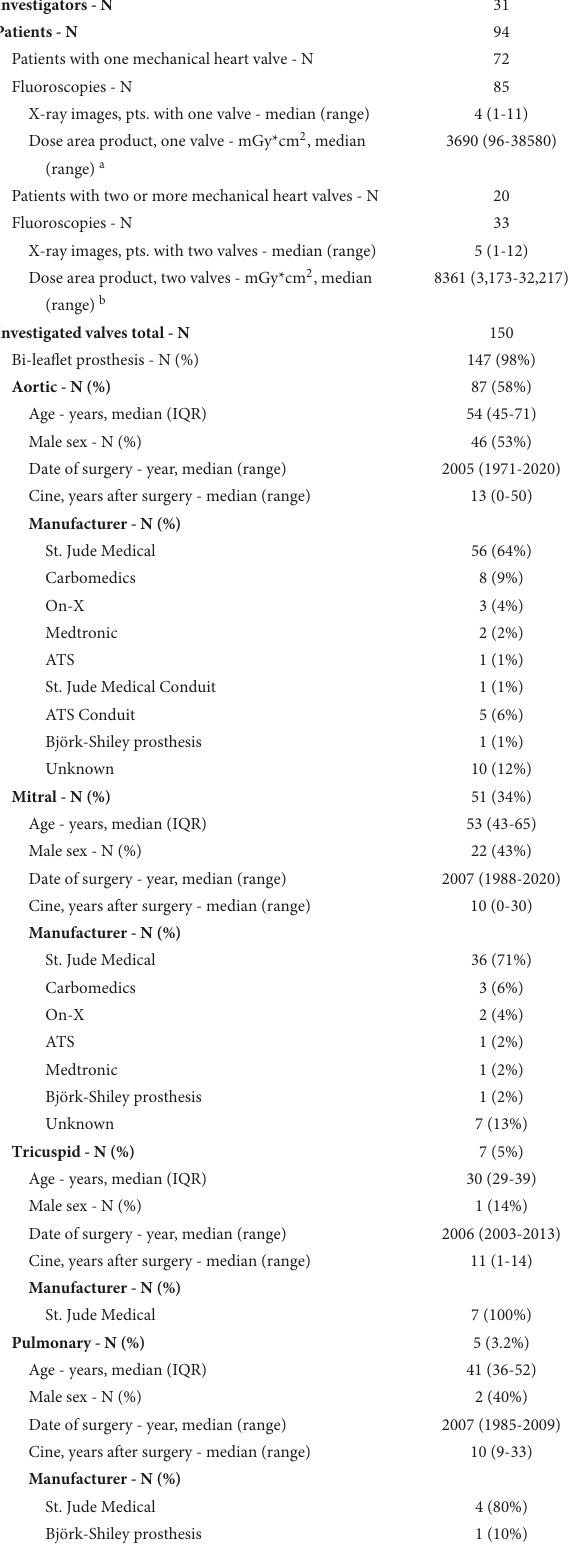
TABLE 1 Patient and cinefluoroscopy